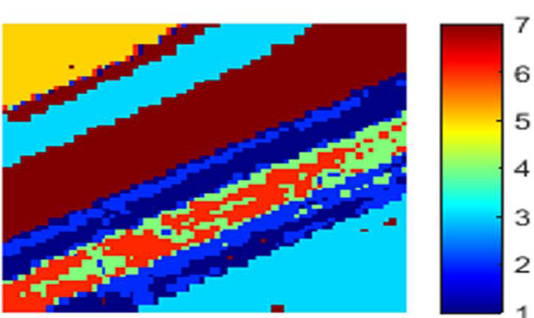
Figure 8: Salinas A Groundtruth classes.